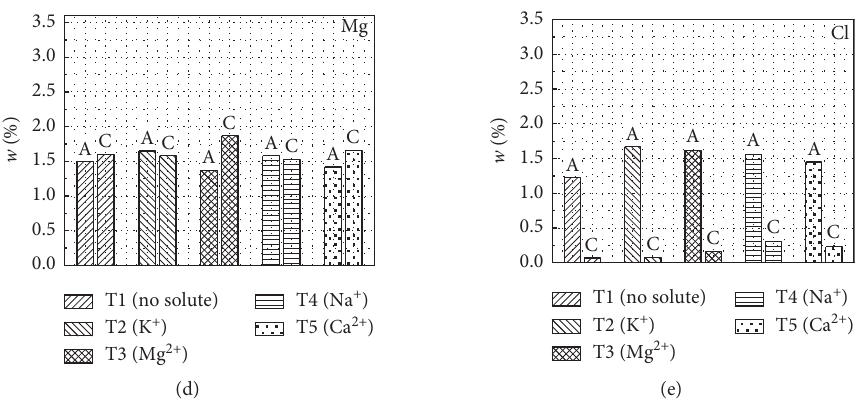
Figure 10: Contents of each element in the soil at the anode and cathode electrodes after the electro-osmosis process. (a) Contents of potassium. (b) Contents of sodium. (c) Contents of calcium. (d) Contents of magnesium. (e) Contents of chlorine.